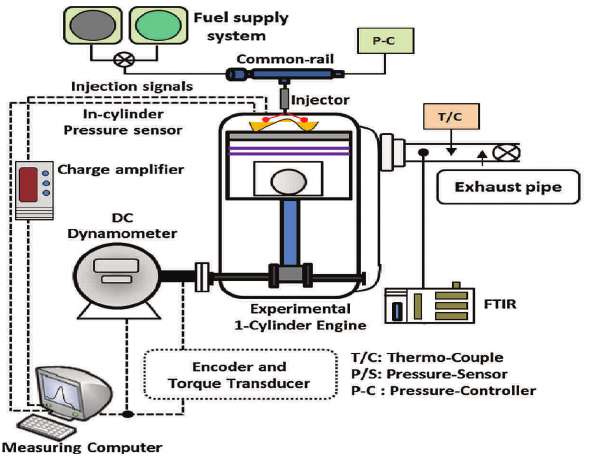
Fig. 6. Schematic diagram of test platform and sampling